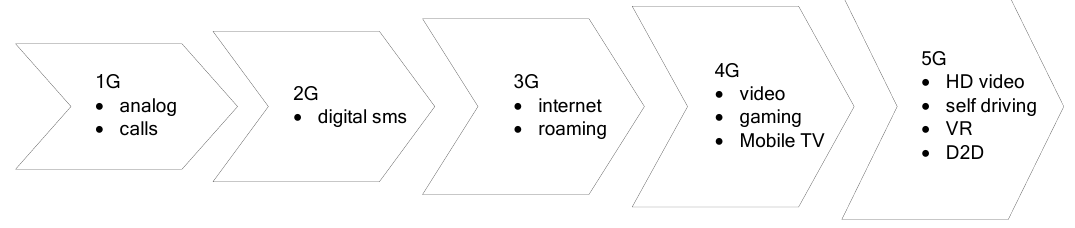
Figure 1. Evolution from 1G to 5G.